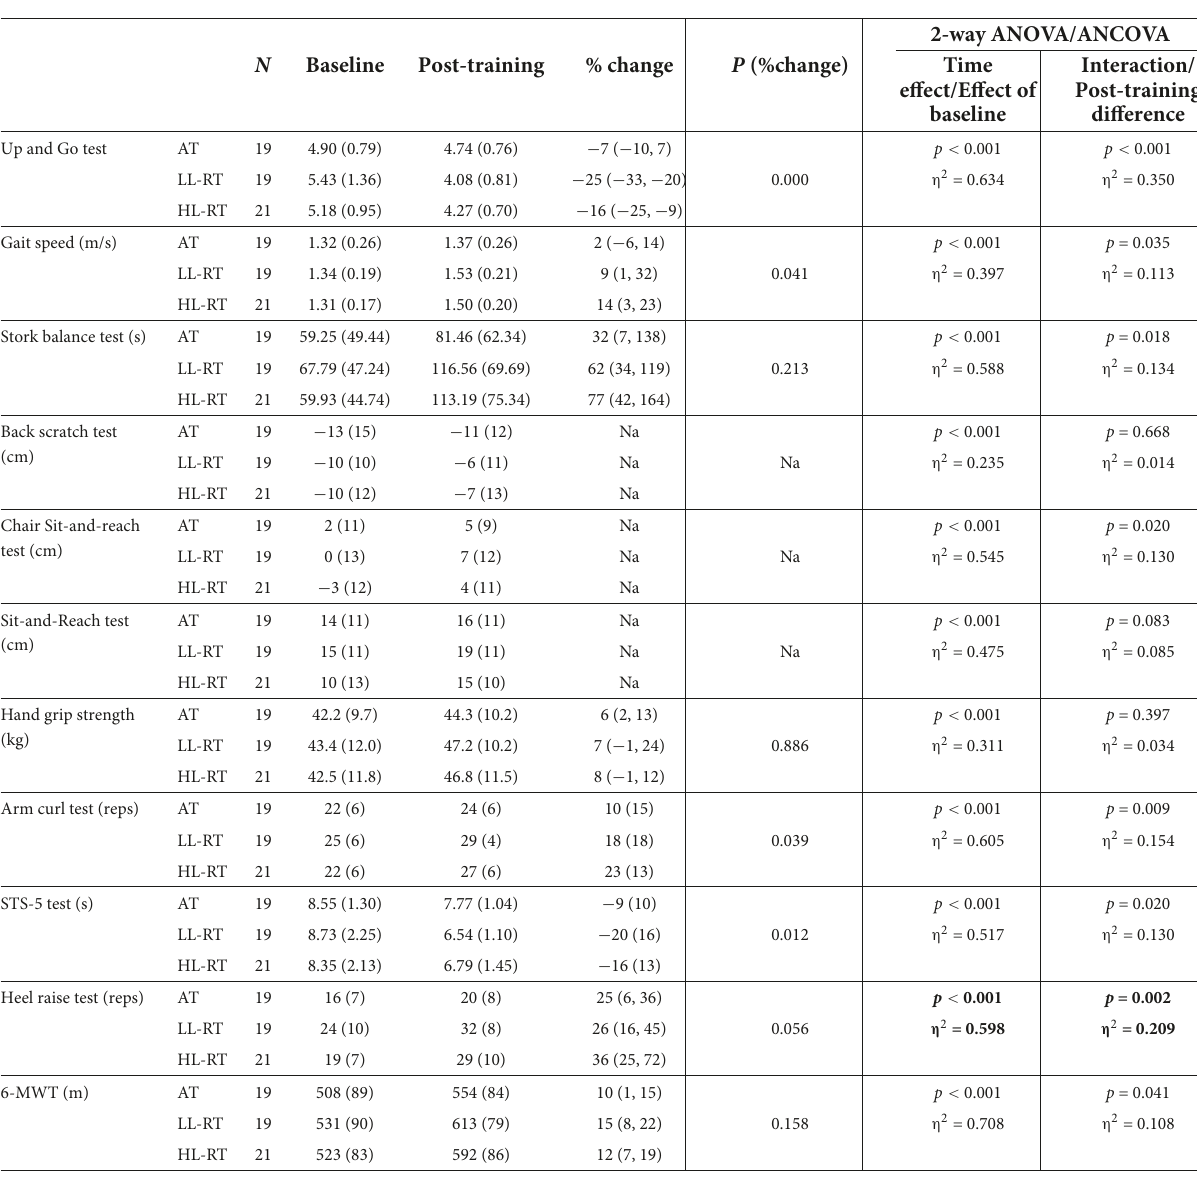
TABLE 3 Physical performance at baseline and